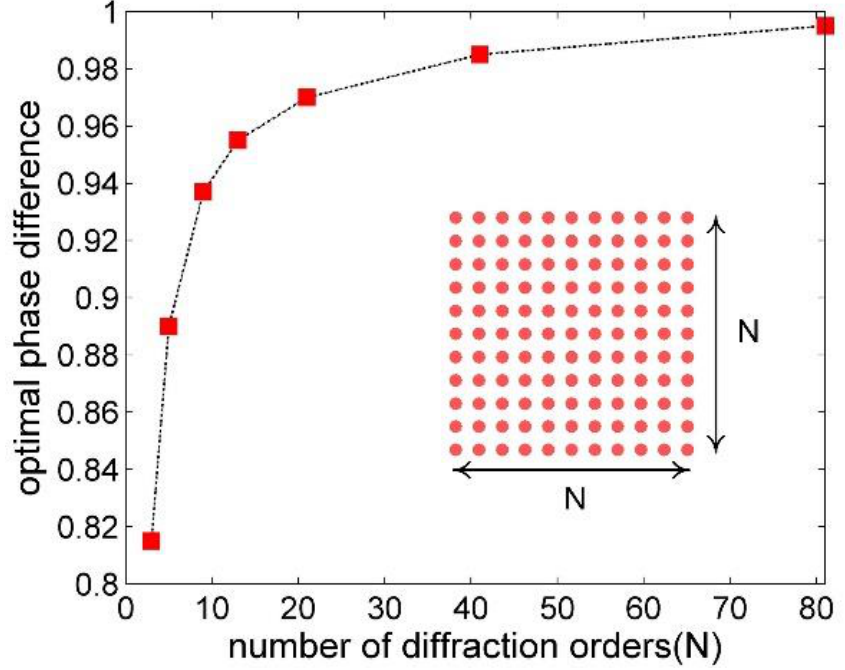
Figure 6. The obtained optimal phase differences for the target patterns with different number of diffraction orders N.